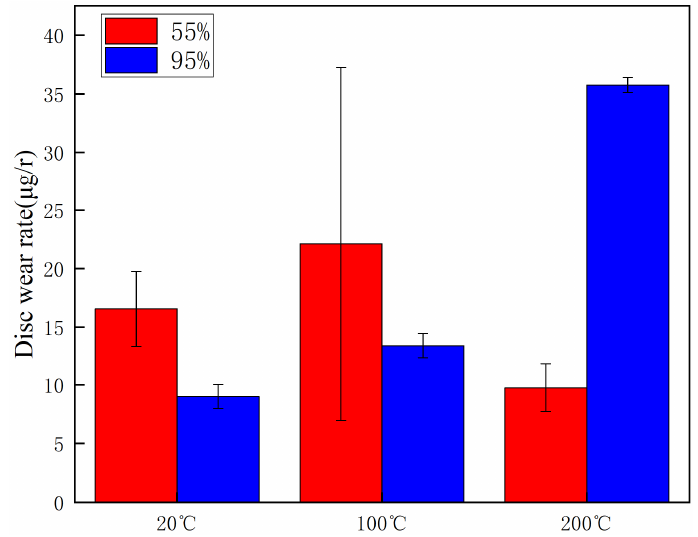
Materials 2023 , 16 , x FOR PEER REVIEW 15 of 33